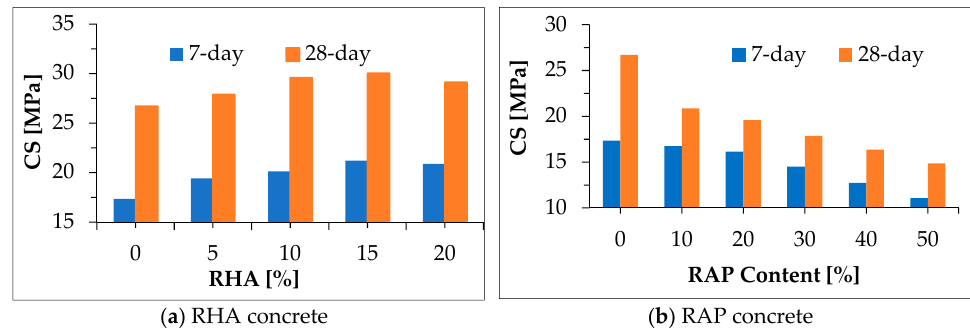
Figure 8 . Compressive strength for RHA and RAP concrete.